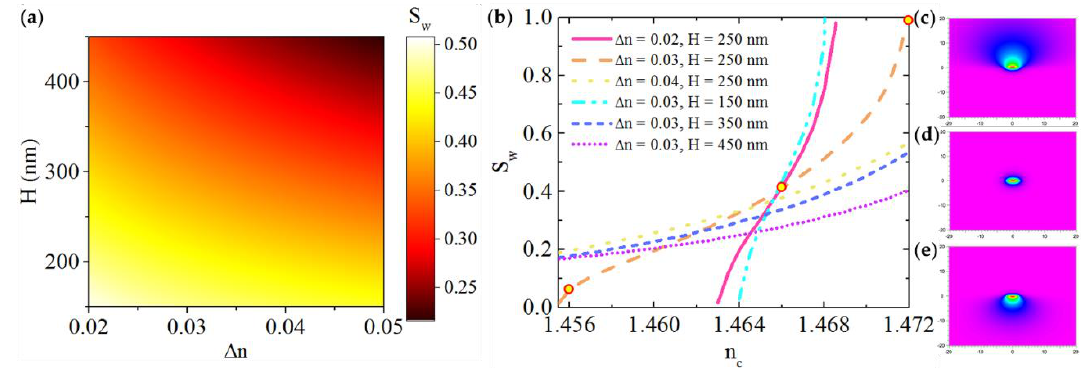
Figure 3. ( a ) Variation of waveguide sensitivity S w (TM fundamental mode) with different ∆ n and H with symmetric field distribution n c = n 0 . ( b ) Variation of waveguide sensitivity S w (TM fundamental mode) with different ∆ n and H when n c changes from 1.456 to 1.472. ( c – e ) The fundamental mode distributions of n c = 1.472, n c = 1.466 and n c = 1.456 at ∆ n = 0.03, H = 250 nm, respectively.